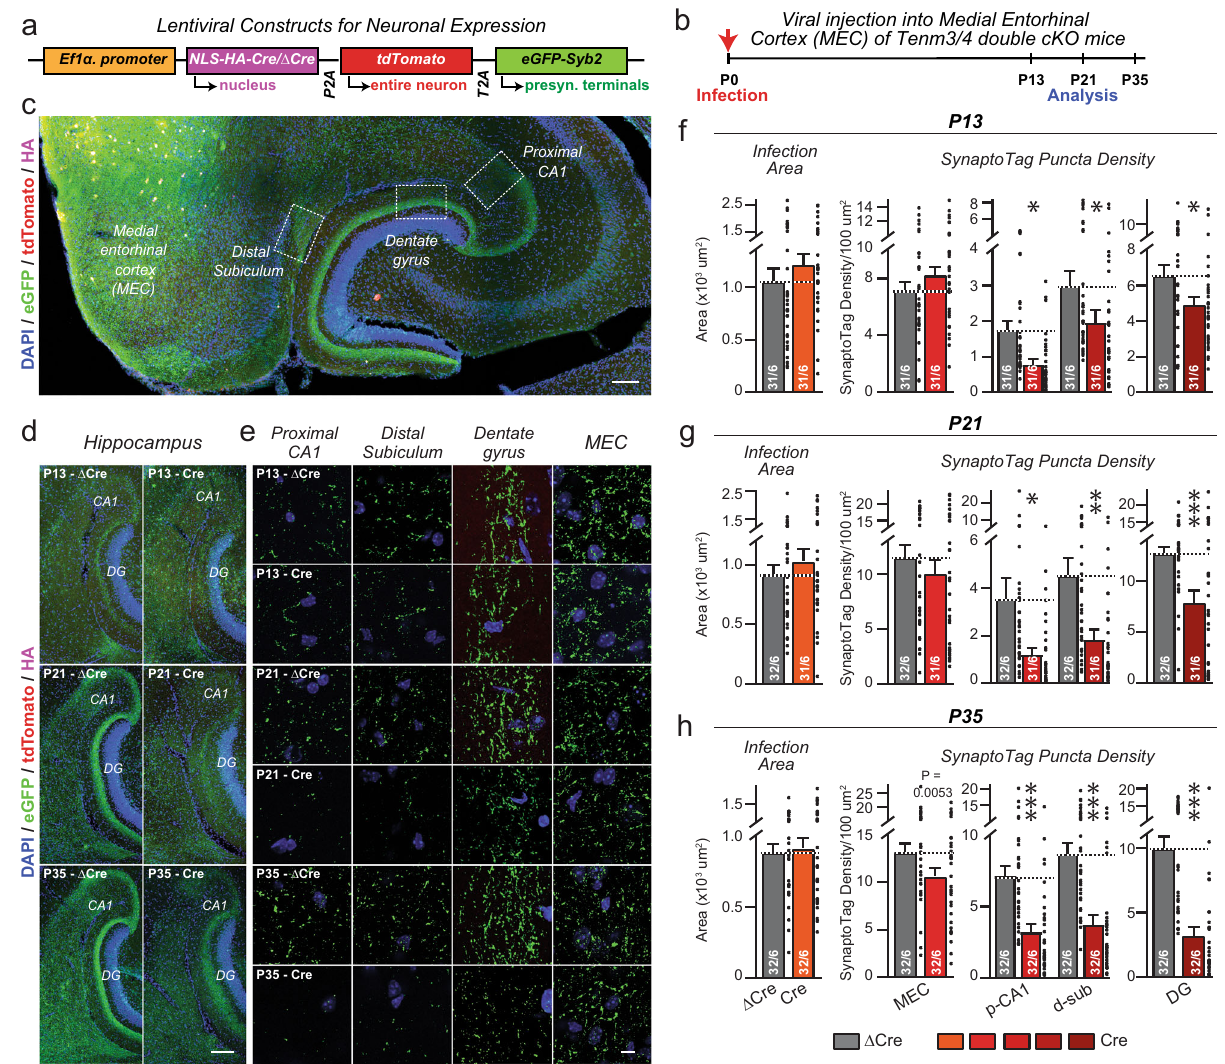
Fig. 6 SynaptoTag mapping reveals that inactivation of Tenm3 and Tenm4 expression in the MEC severely impairs synapse formation by entorhinal cortex projections onto neurons in the proximal CA1, distal subiculum, and dentate gyrus. a Design of SynaptoTag lentiviruses used for the presynaptic tracing of synaptic connections. The Ef1 α promoter drives the expression of HA-tagged Cre or Δ Cre, tdTomato, and a presynaptic eGFP-synaptobrevin-2 fusion protein (eGFP-Syb2). The HA signal visualizes the viral injection area, the soluble tdTomato signal visualizes axonal projections, whereas the eGFP- Syb2 signal visualizes presynaptic specializations. Sections were stained for HA (magenta), tdTomato (red), eGFP (green) and DAPI (blue). b Experimental strategy. The MEC neurons of Tenm3/4 DcKO mice were stereotactically injected with the SynaptoTag lentiviruses at P0, and mice were analyzed by imaging at P13, P21, and P35. c Representative image of a horizontal section of the hippocampal formation from a SynaptoTag experiment. Boxes illustrate the areas that were analyzed by eGFP-Syb2 signal quanti fi cation. Representative low ( d ) and higher resolution images ( e ) at P13 (top), P21 (middle), or P35 (bottom) of the SynaptoTag signals in hippocampal sections after infection of the MEC with control ( Δ Cre, left) and test SynaptoTag lentiviruses (Cre, right). The panels in d show overviews, while the panels in e depict the indicated areas of the hippocampal formation. f – h Quanti fi cations of the SynaptoTag signal reveal that the Tenm3/4 deletion in the MEC causes a large decrease in MEC-derived synapses in the proximal CA1, distal subiculum, and dentate gyrus, but not in the MEC itself, at all time points analyzed ( f , P13; g , P21; h , P35). Left graphs show the size of the lentivirally infected areas in the MEC; right graphs show the SynaptoTag puncta density in the MEC, proximal CA1 (p-CA1), distal subiculum (d-sub), and dentate gyrus (DG). Data are means ± SEM; numbers of sections/mice are indicated in the bars. Statistical signi fi cance was assessed using two-sided Student ’ s t-test and Two-way ANOVA (* p < 0.05; ** p < 0.01; *** p < 0.001). For additional experiments and quanti fi cations, see Supplementary Fig. 9. Scale bars: 0.5 mm ( c ), 0.2 mm ( d ) and 20 µ m ( e ).